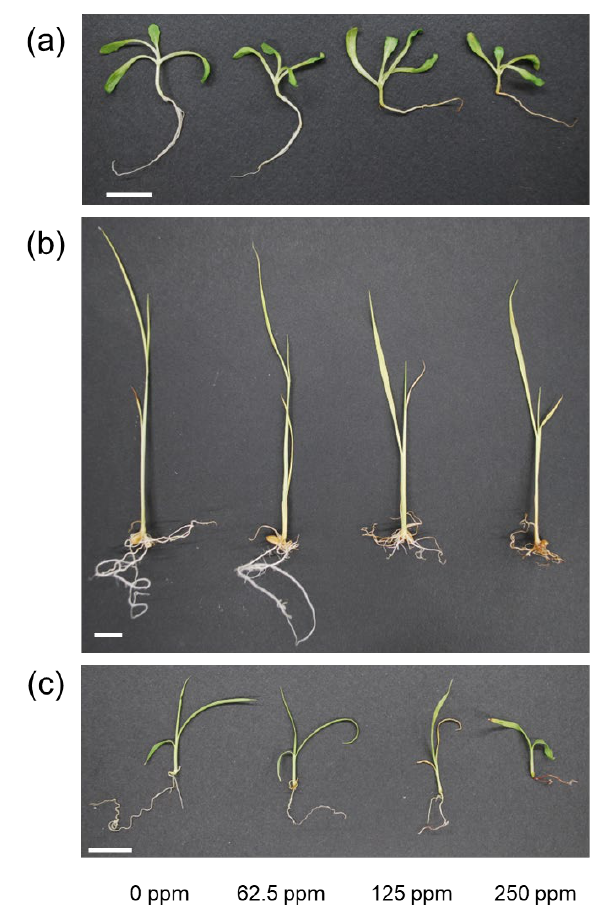
Figure 3. Phytotoxicity of oosporein to seedling growths of Lactuca sativa , Oryza sativa , and Miscanthus sinensis . ( a – c ) show seedlings of L. sativa , O. sativa , and M. sinensis after incubation in oosporein solution at each concentration for 10 days, respectively. Scale bars represent 10 mm.